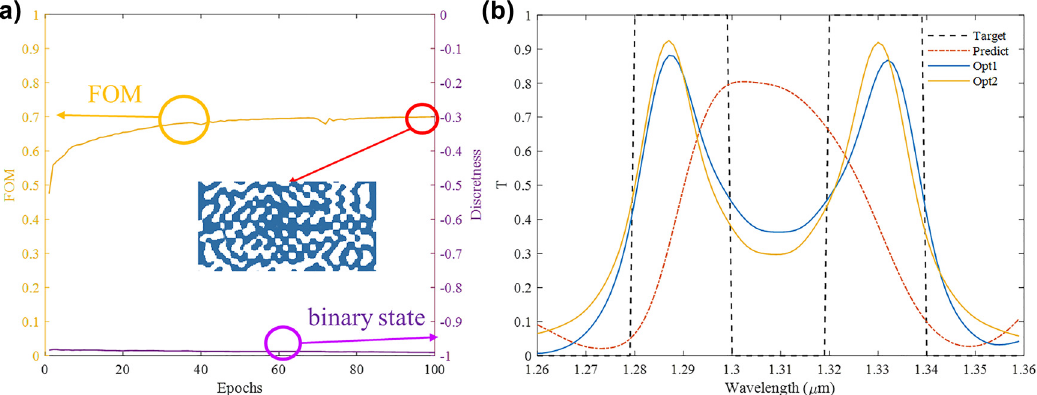
Figure 7: Optimization of a new wavelength filter with two opening windows. (a) Optimization procedure with pre-trained DNN, where yellow line represents the FOM and purple line represents the discreteness. The inset figure shows the further optimized structure. (b) Black and orange dash lines represent the target and predicted optical spectra, while blue (Opt1) and yellow (Opt2) solid lines represent optimized spectra with and without pre-trained